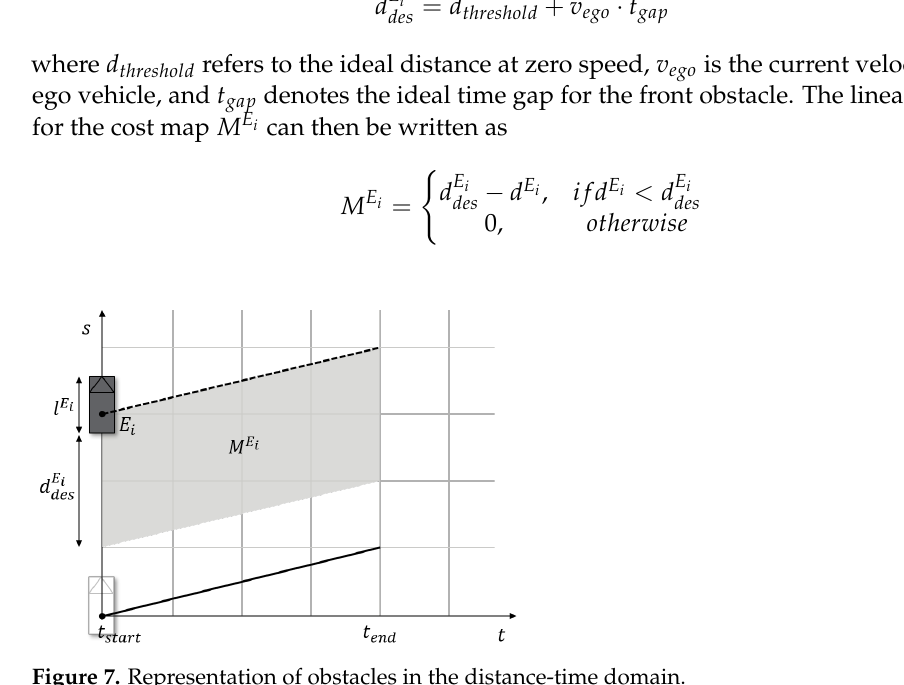
Figure 7. Representation of obstacles in the distance-time